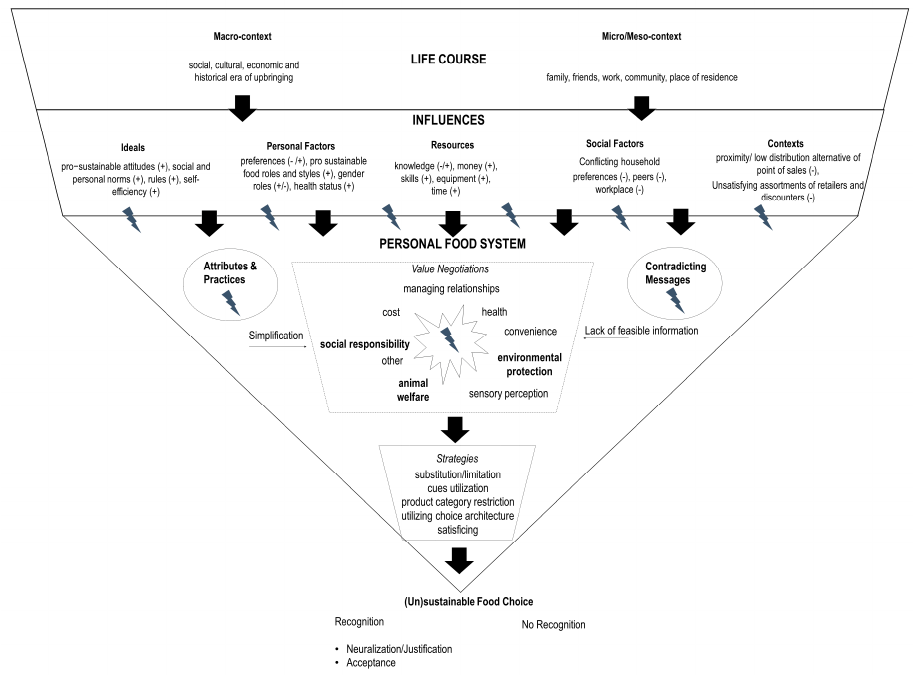
Figure 5. The food choice process model for consumers involved with sustainable food choice based on the model from Furst et al. (1996) [51] and Connors et al. (2001) [60].